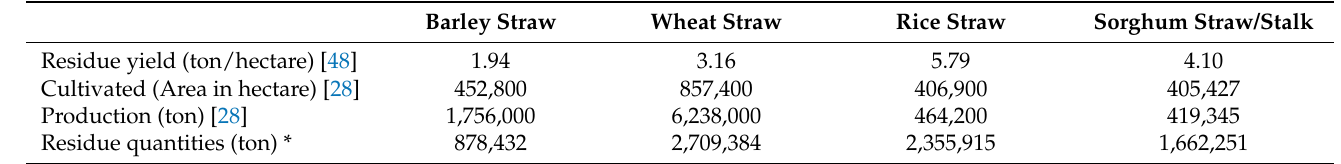
Table 4. Seasonal-crop production in Iraq. Barley Straw Wheat Straw Rice Straw Sorghum